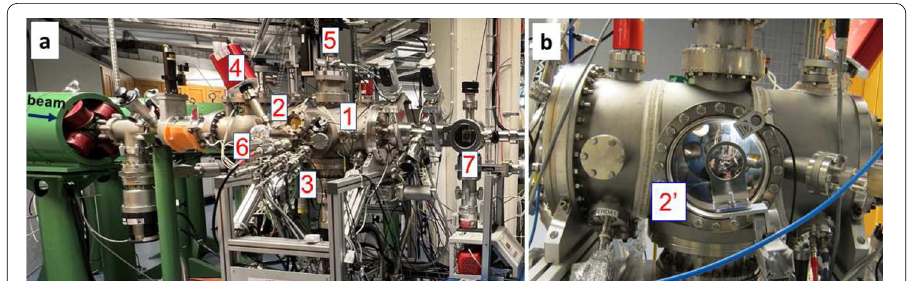
Figure 5 SIGMA system shown from the both sides ( a ) and ( b ) of the apparatus: the vacuum chamber – 1; viewing ports on both sides of the chamber – 2 and 2’; triple evaporator – 3; residual gas analyzer – 4; sample manipulator – 5; ion gun – 6; load-lock chamber –